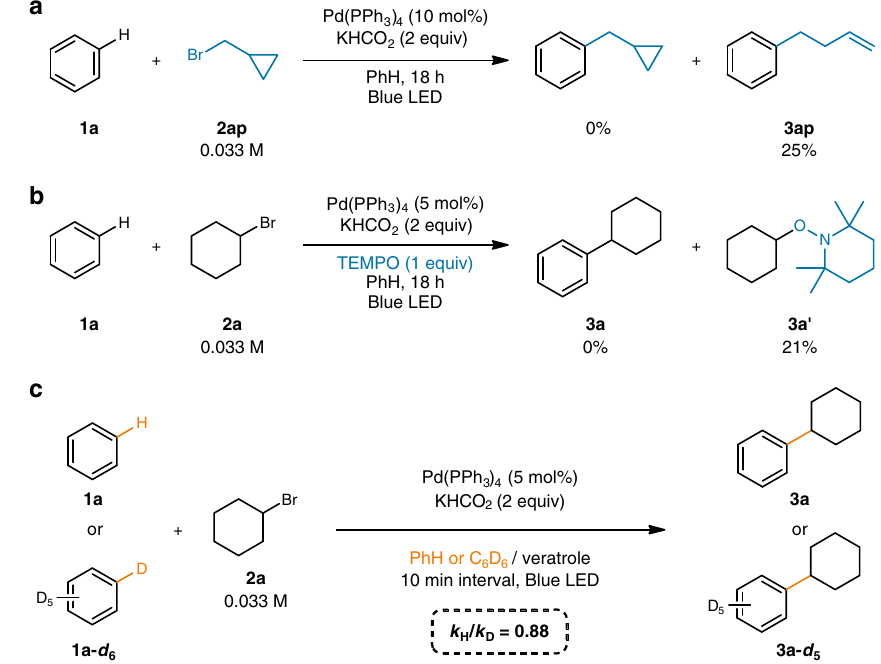
Fig. 2 Mechanistic studies. a Radical clock experiment. b Radical scavenger experiment. c Kinetic isotope effect measurement.